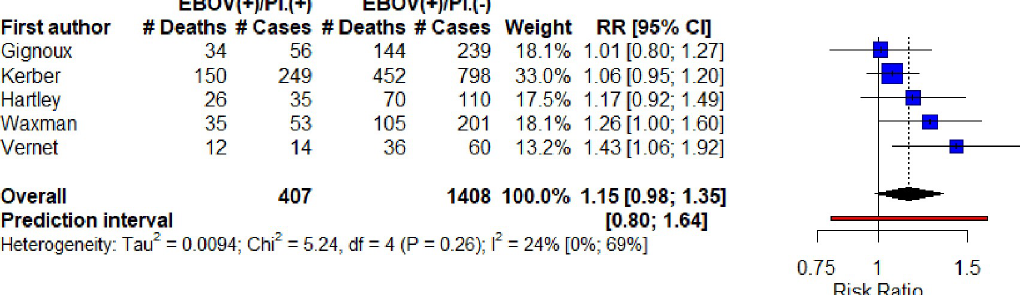
Fig 5. Meta-analysis of unadjusted risk ratio estimates for the effect of Plasmodium infection on EVD-related mortality (all ZEBOV) including only studies with malaria RDT as the diagnostic.